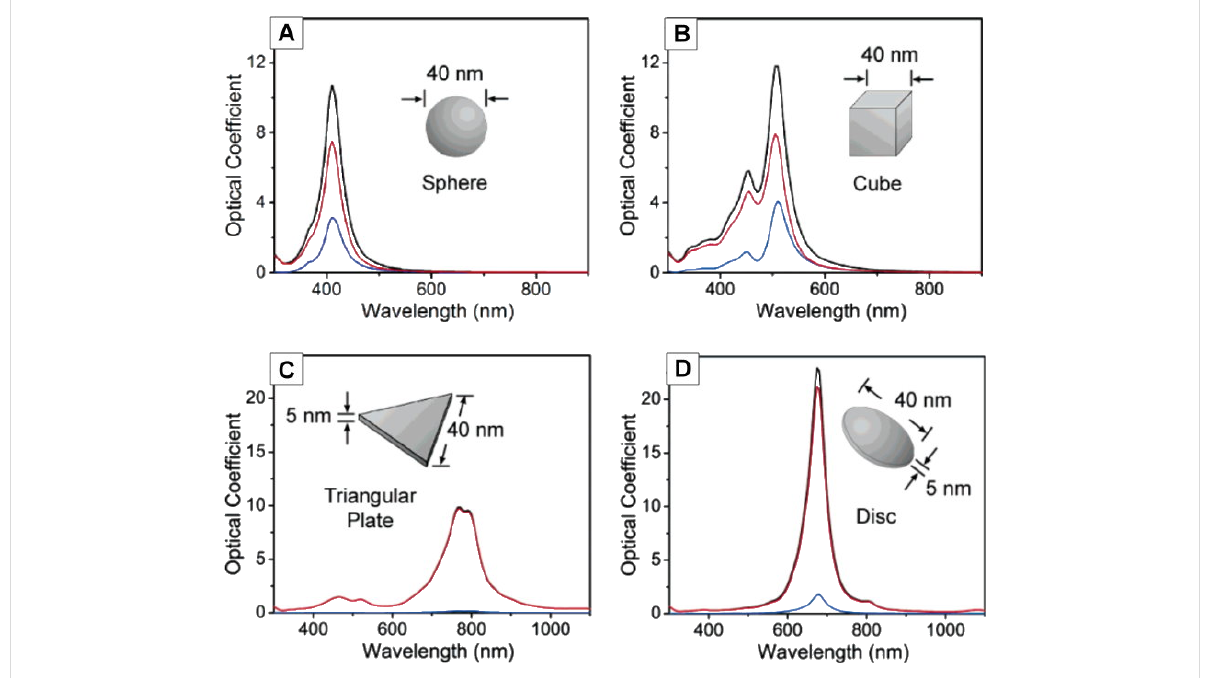
Figure 11: Calculated UV–vis extinction (black), absorption (red), and scattering (blue) spectra of silver nanostructures, illustrating the effect of the shape of a nanostructure on its spectral characteristics. An isotropic sphere (A) exhibits spectra with a single resonance peak. The spectra of an anisotropic cube (B), a triangular plate (C), and a circular disc (D) are also shown. Reprinted with permission from [63], Copyright 2006 American Chemical Society.